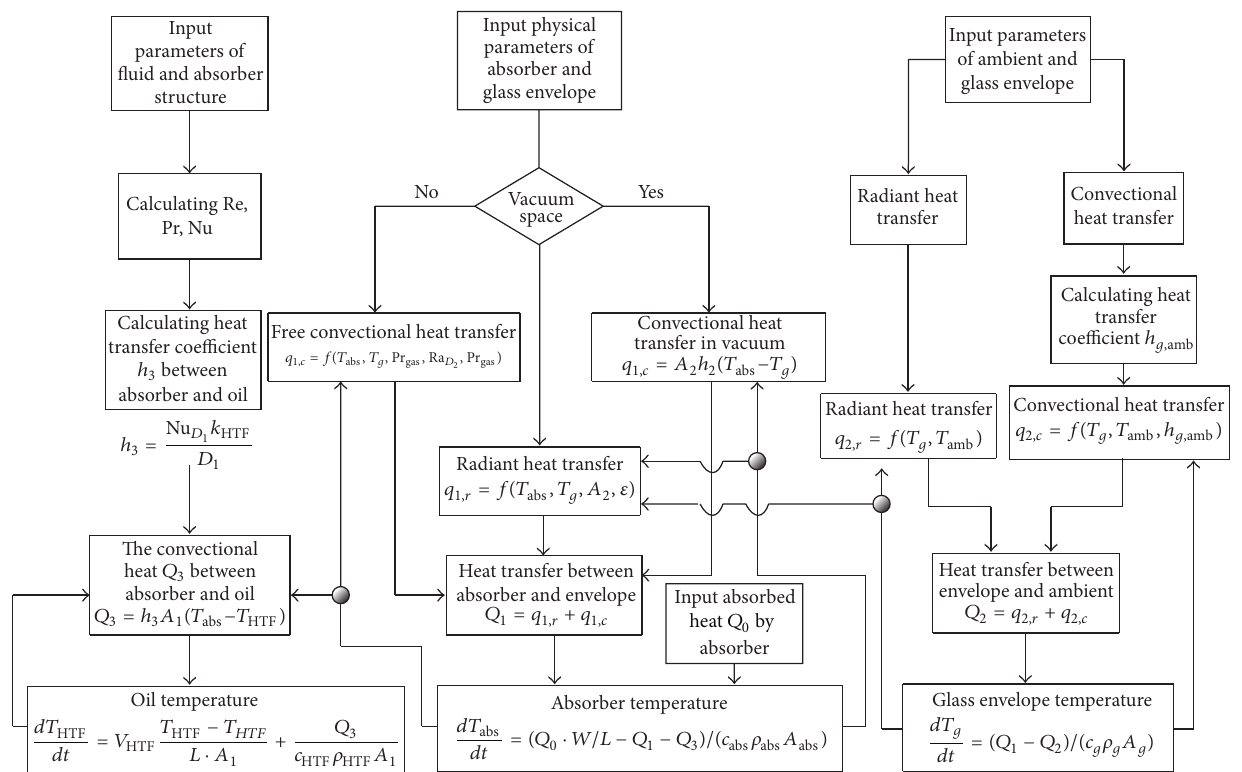
Figure 4: The schematic flow chart of the program to simulate the thermal oil system.